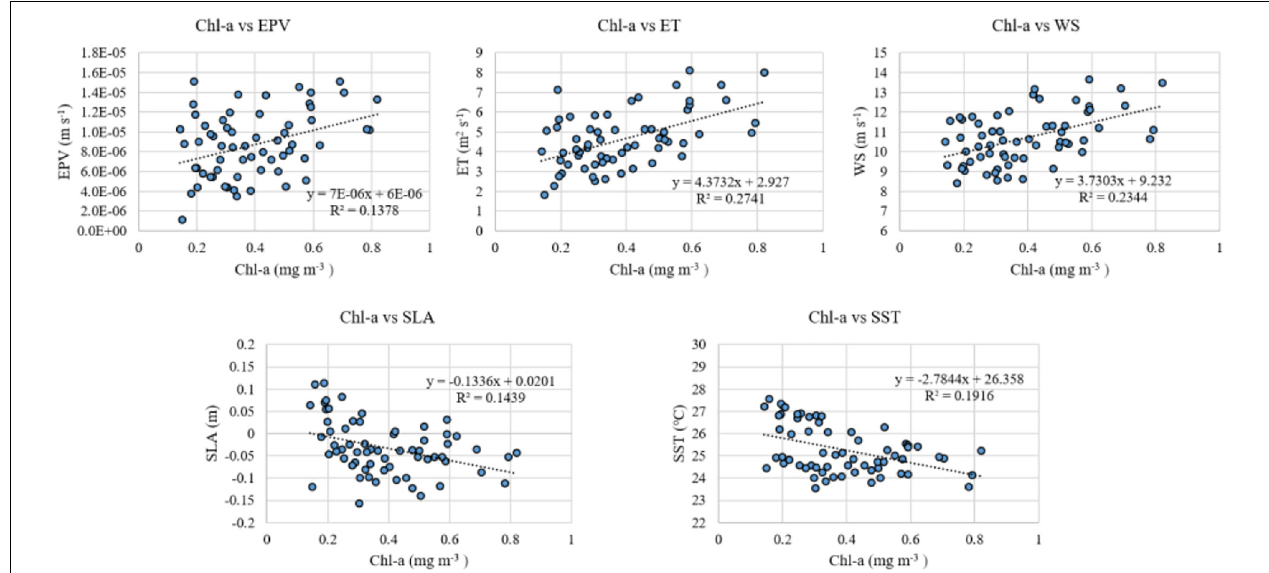
FIGURE 10 | Scatter diagrams of monthly Chl- a , EPV, ET, WS, SLA, and SST in winter averaged for the selected regions, respectively. The boxes used in time series of Chl-a, EPV, ET, SLA, and SST are chosen according to the rule mentioned in Section “The Sampling Region.” TABLE 3 | The multiple correlation and partial coefficients between the Chl- a and other oceanic factors.